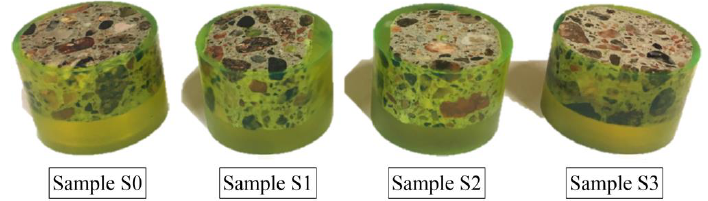
Figure 3. Samples prepared for creep tests based on the indentation method.